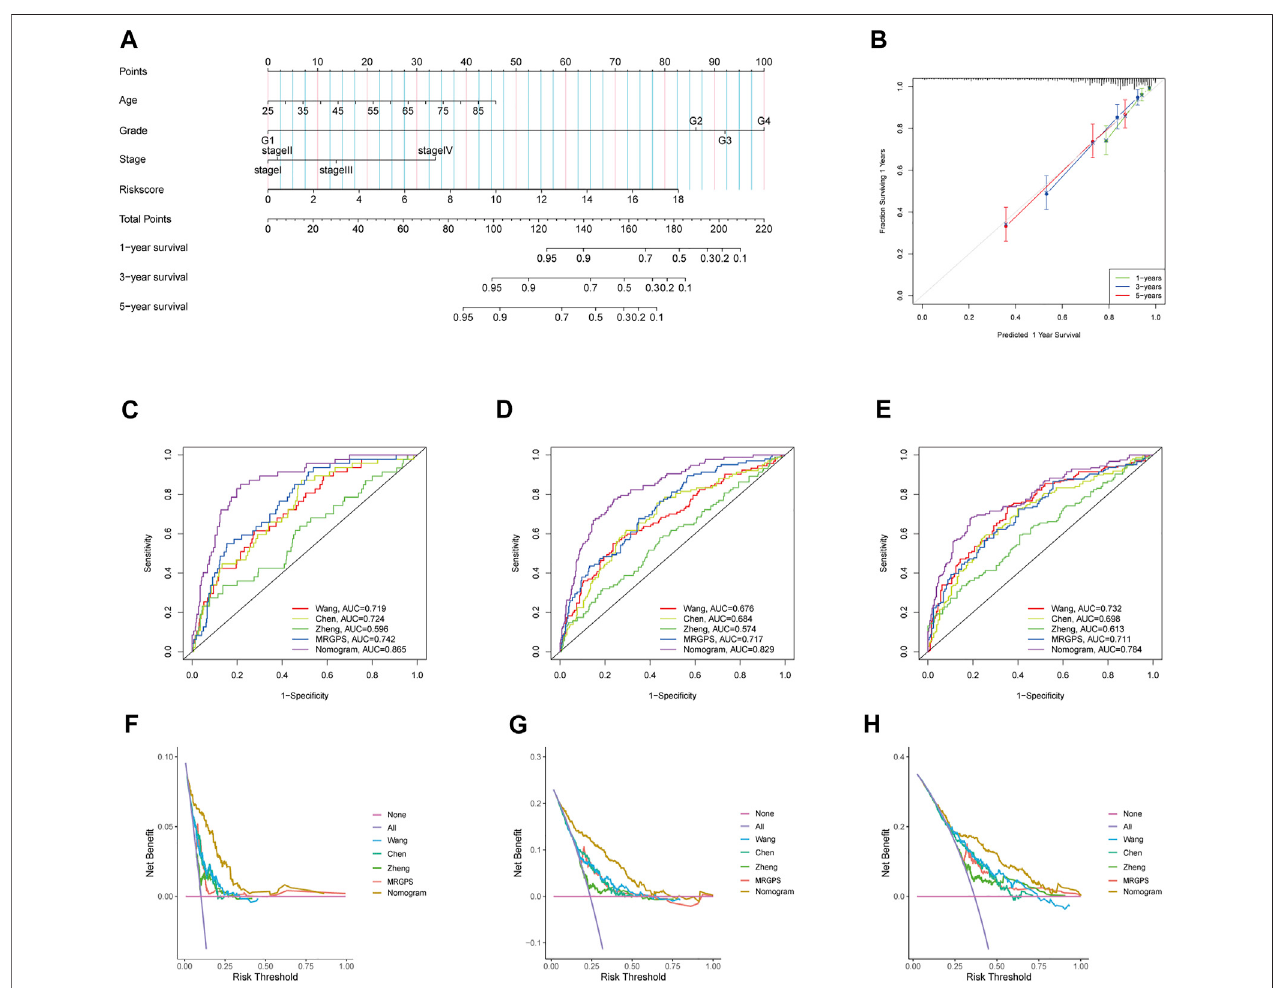
FIGURE 8 | Construction and veri fi cation of nomogram. (A) The prognostic nomogram constructed based on the risk score of MRGPS and clinicopathological parameterspredictedthesurvivalrateofTCGA-ccRCCpatientsat1-,3-,and5-years. (B) Calibrationcurvesshowedtheconcordancebetweenpredictedandobserved 1-, 3-, and 5-years survival rates. AUCs of the nomogram, MRGPS and other signatures in ROC analysis were calculated at (C) 1-, (D) 3-, and (E) 5-years OS time in TCGA-ccRCC cohort. Decision curve analyses (DCA) for nomogram, MRGPS and other signatures at (F) 1-, (G) 3-, and (H) 5-years to assess clinical utility in TCGA-ccRCC